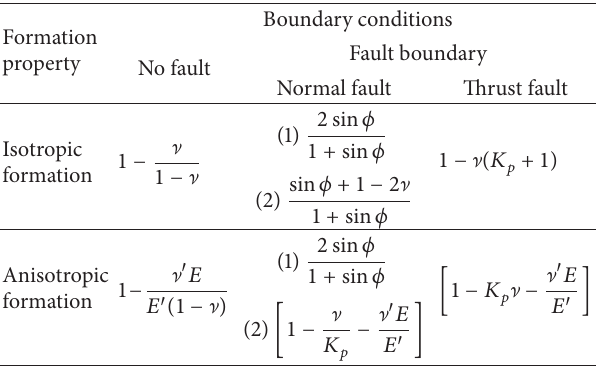
Table 1: The value of proportional coefficient 𝐾 .